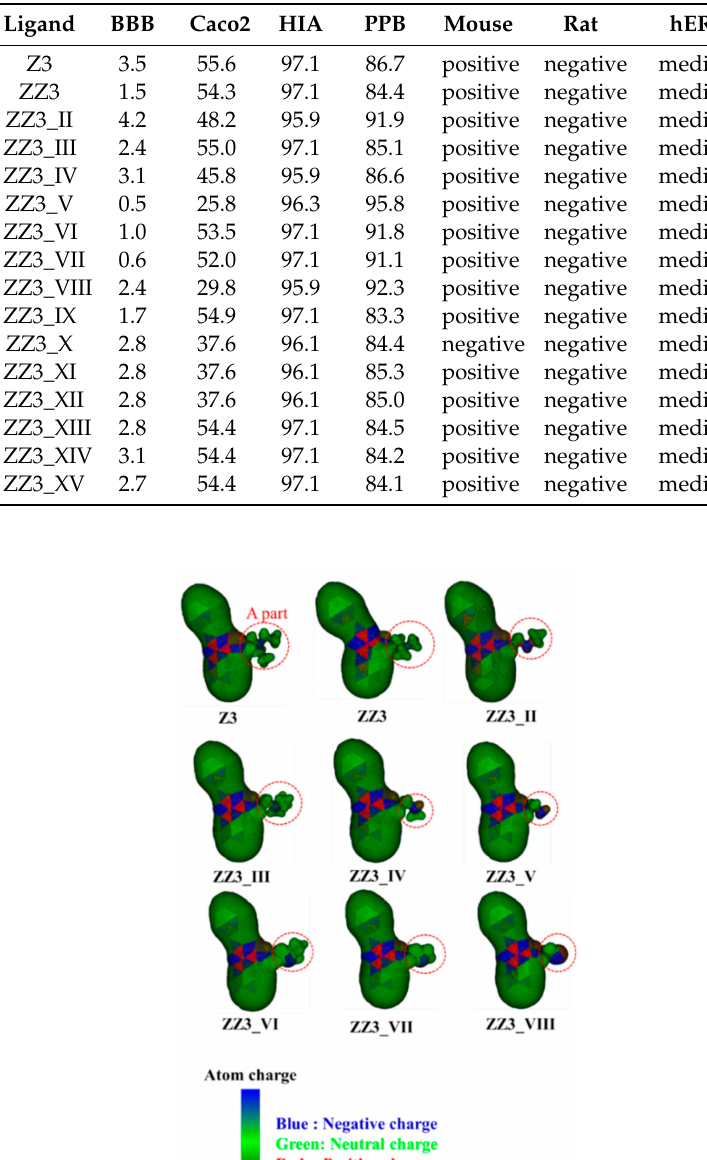
Table 2. Pharmacokinetic properties predicted by PreADMET [18] for Z3, ZZ3 and its ZZ3 derivatives created by SwissBioisostere [16]. Blood-brain barrier (BBB) penetration is the steady-state concentration of radiolabeled compounds in brain and peripheral blood. Caco2 cell permeability (Caco2) (nm / sec) is values for evaluating intestinal absorption of drug candidates. Human intestinal absorption (HIA) is a value-predicted human intestinal absorption rate. Plasma protein binding (PPB) indicates the strength to protein. Toxicity for carcino-mouse (Mouse) and carcino-rat (Rat), and the inhibition risk of human ether-a-go-go related gene (hERG). The acceptable ranges of these properties are as follows. (1) BBB larger than 2 suggests high absorption to central nervous system (CNS), while BBB less than 0.1 indicates very low absorption. (2) Caco2 permeability (nm / sec) is larger than 70 for high permeability, while it is smaller than 4 for low permeability. (3) HIA calculated at pH 7.4 is between 0 and 20% for poor absorption, 20–70% for moderate absorption, and 70–100% for fair absorption. (4) PPB larger than 80% indicates strong binding to protein.